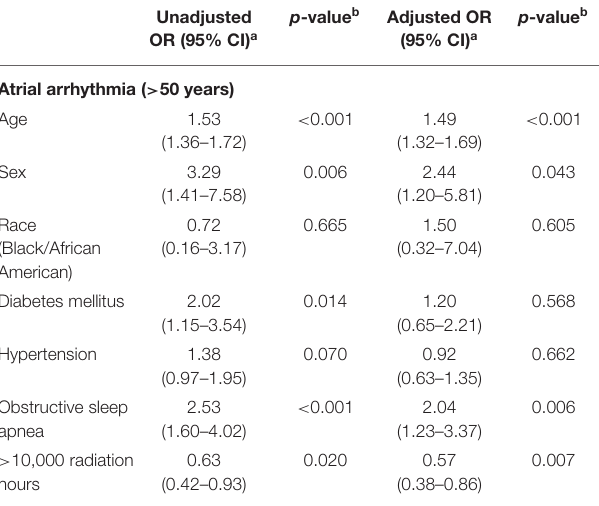
TABLE 2 | Prevalence of medical conditions based on hours of radiation. TABLE 3 | Odds of atrial arrhythmia in